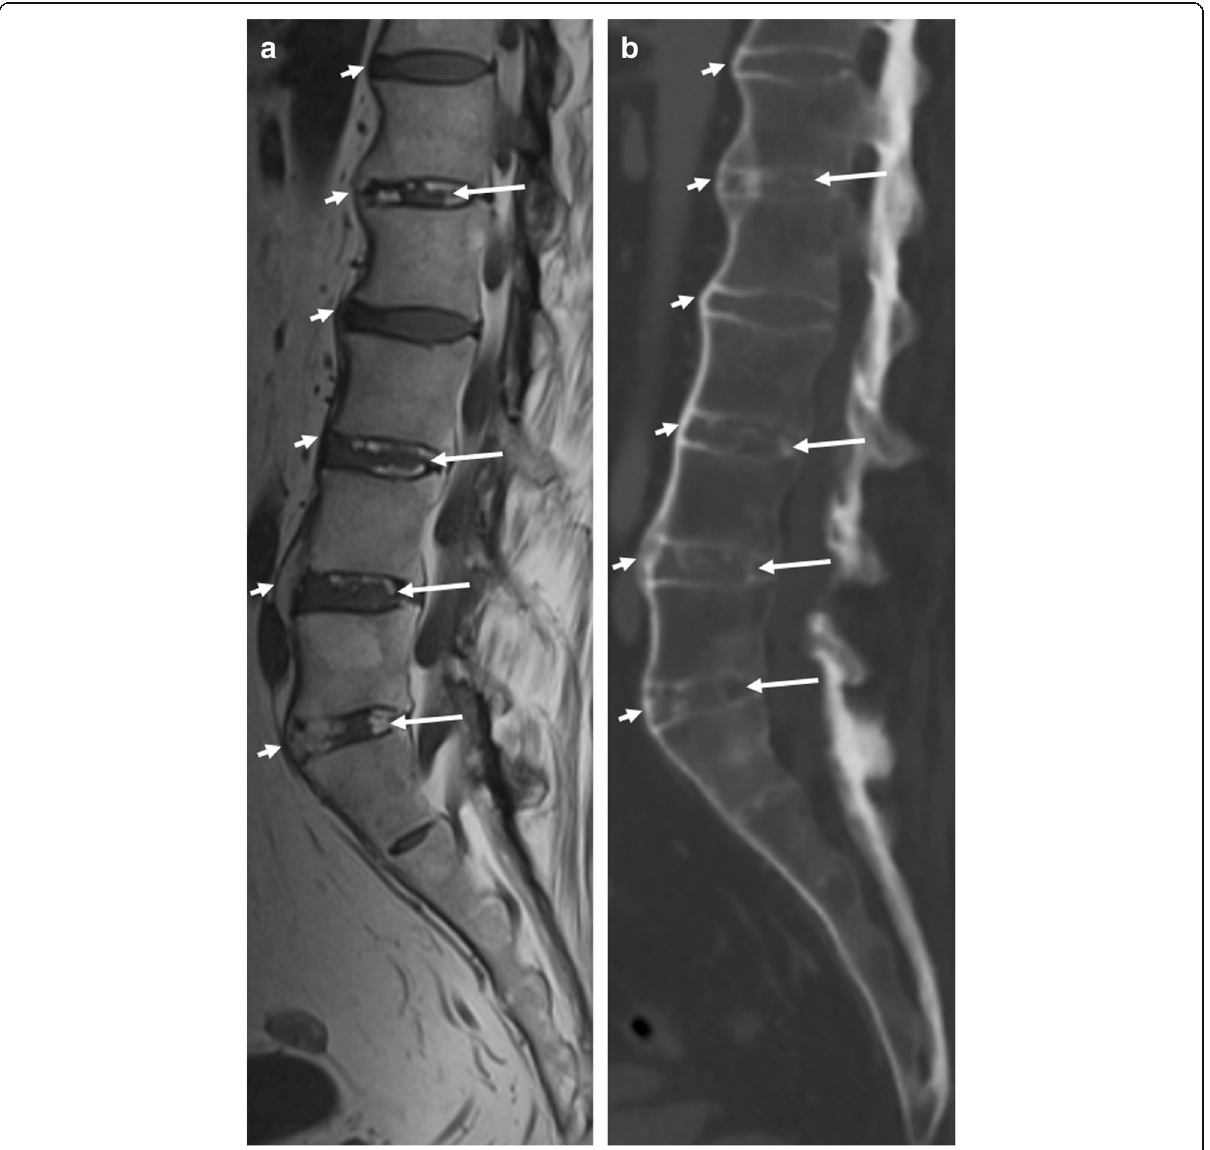
Fig. 5 Discal high signal intensity on T1-weighted MR images. a Sagittal T1-weighted MR images of the lumbosacral spine acquired in a 45-year- old man with SpA show signal intensity (long arrows) similar to that of adipose tissue within the intervertebral disc. b Computed tomography (CT) of the same intervertebral discs show discal calcification (long arrows). Also, notice the discordance in the visibility between CT and MRI for the evaluation of anterior bridging syndesmophytes (short